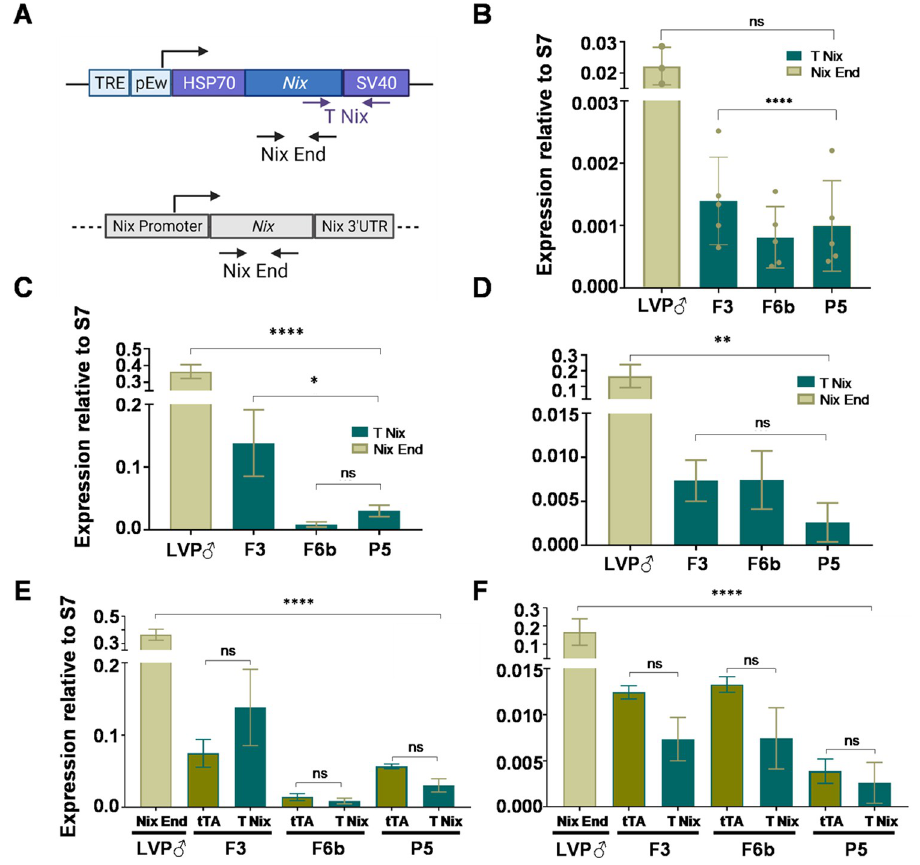
Fig 7. Transgenic Nix expression profile in transgenic mosquitoes. ( A ) Schematic representation of the pTRE-Nix/ NixPro-tTA transgene (top) and endogenous Nix gene (bottom) and Nix T (specific for the transgene) and Nix End (binds on the Nix open reading frame on both the transgene and endogenous Nix) primer binding localization. ( B ) Quantification of endogenous or transgenic Nix transcripts in F3, F6b and P5 transgenic adult female mosquitoes and Liverpool males of at least 3 experiments containing 5 mosquitoes each. Quantification of accumulated transcript in the maxillary palps ( C, E ) and antennae ( D, F ) from 25–30 male Liverpool or female transgenic of transgenic Nix and Nix endogenous ( C-D ) and tTA and transgenic Nix ( E-F ). Columns represent the mean values and bars the standard. One-way ANOVA test was used to determine the statistical significance; ns: P > 0.05; ���� : P < 0.0001. T Nix, transgenic Nix transcript; Nix End, endogenous Nix transcript, tTA, tetracycline transactivator. Using two sets of primers (Fig 7A), transcript abundance in adult females was investigated, with no significant difference observed in transgenic Nix expression between F3, F6b and P5 transgenic lines, despite strong differences in masculinization (Fig 7B). However, they dis- played significant lower levels in comparison to Nix expression in the wild type males (~15, ~44, and ~32 times lower in F3, F6b, and P5 respectively) (Fig 7B). We further assayed the expression levels of transgenic Nix and tTA in maxillary palps and antennae in the transgenic females and endogenous Nix expression in LVP males to determine if there were differences in somatic expression of transgenic Nix among the transgenic lines and LVP males as well as to investigate possible differences in tTA expression in relation to transgenic Nix that could indi- cate potential problems in the Tet-off system. LVP males expressed significantly more endoge- nous Nix than masculinized females expressed transgenic Nix in both tissues (Fig 7C and 7D). In the antennae, F3 females had higher expression of transgenic Nix in comparison to F6b and P5 (Fig 7C) despite the fact that we never observed masculine traits in this tissue in any